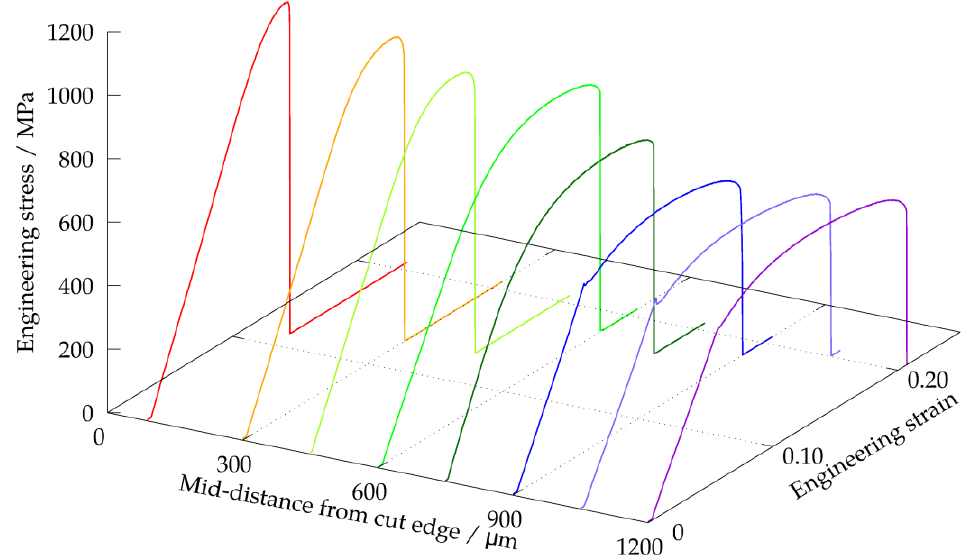
Figure 8. Stress-strain curves obtained at different depths from the cut edge.